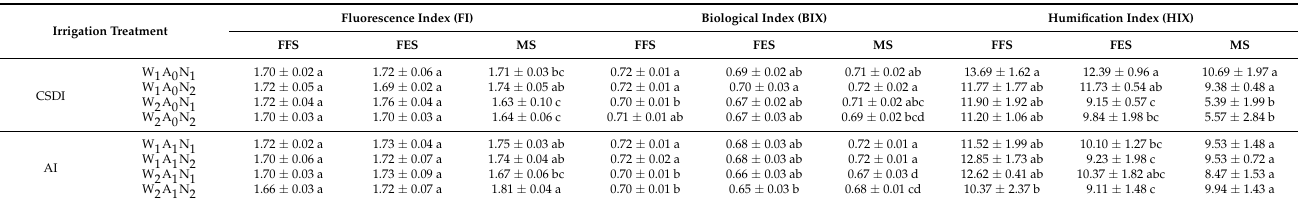
Table 5. Fluorescence spectrum indices of soil DOM at different growth period.